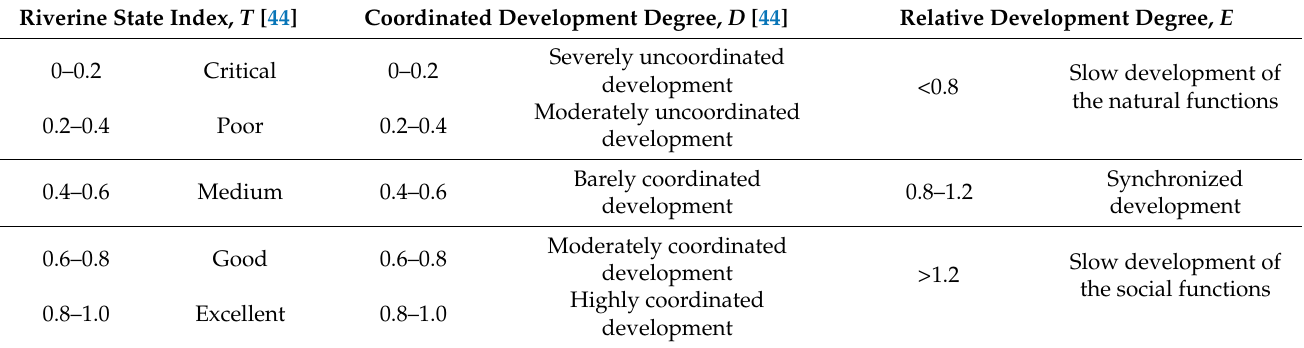
Table 3. The evaluation criteria and classification standards for the riverine state index, coordinated development degree, and relative development